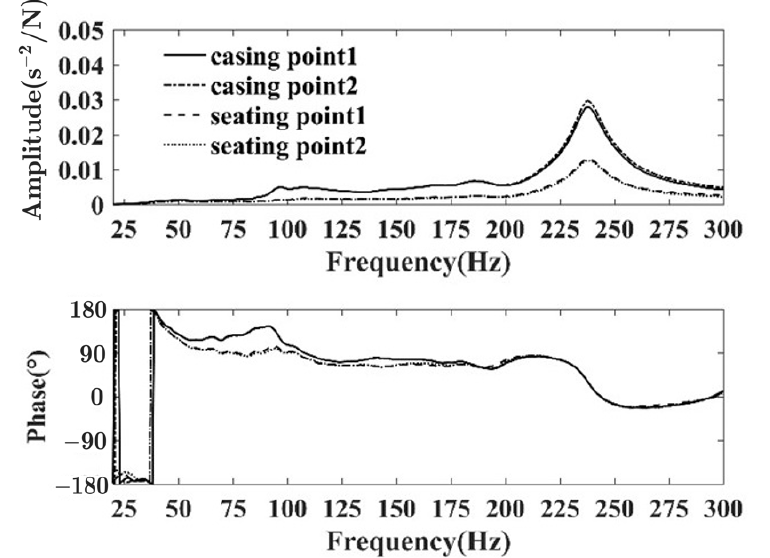
Figure 2. Acceleration frequency response